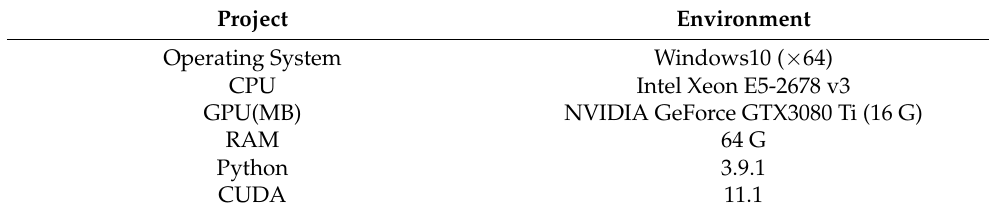
Table 3. Experimental environment configuration.